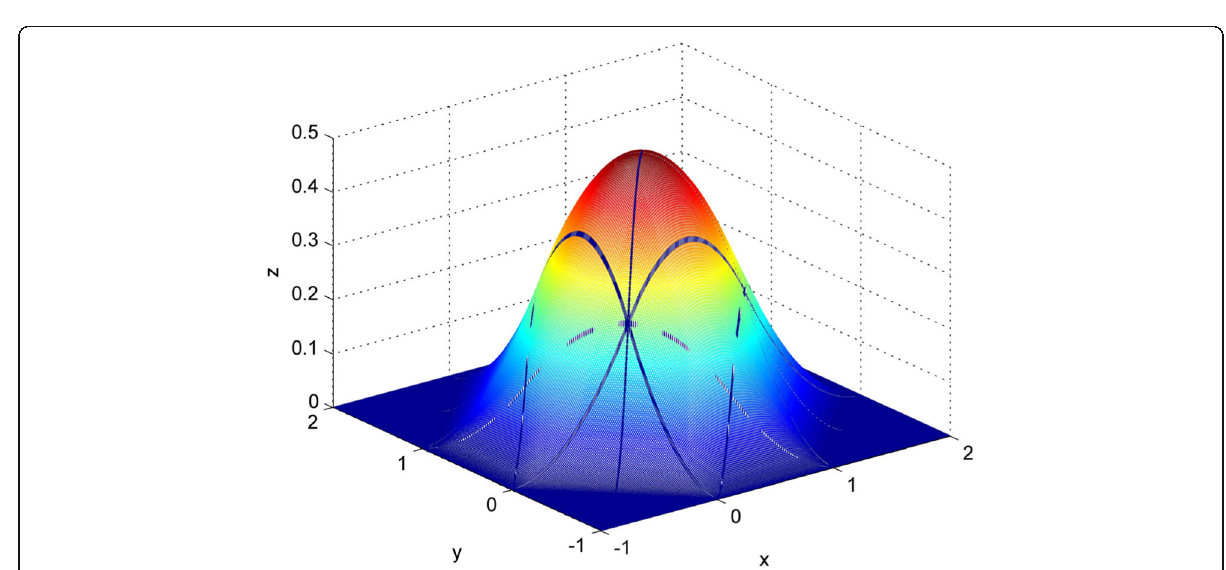
Fig. 5 Basis function